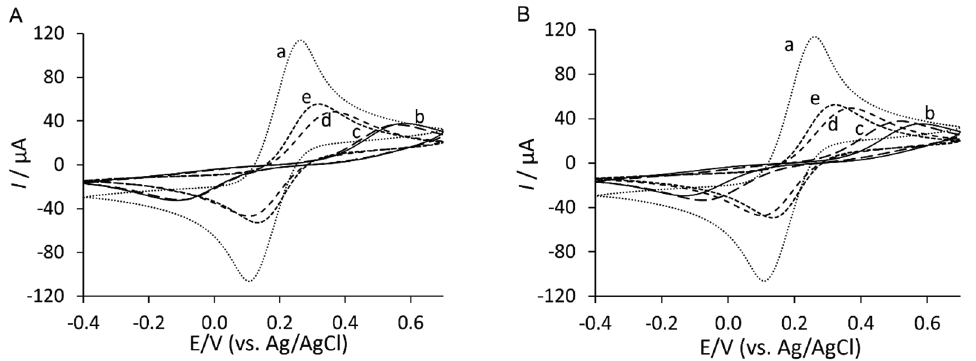
Figure 2. Cyclic voltammograms of the step-wise surface fabrication of ( A ) YNGRT-Au and ( B ) VLGXE-Au: (a) bare Au; (b) Lip-NHS; (c) peptide; (d) ethanolamine; and (e) 2-mercaptoethanol.